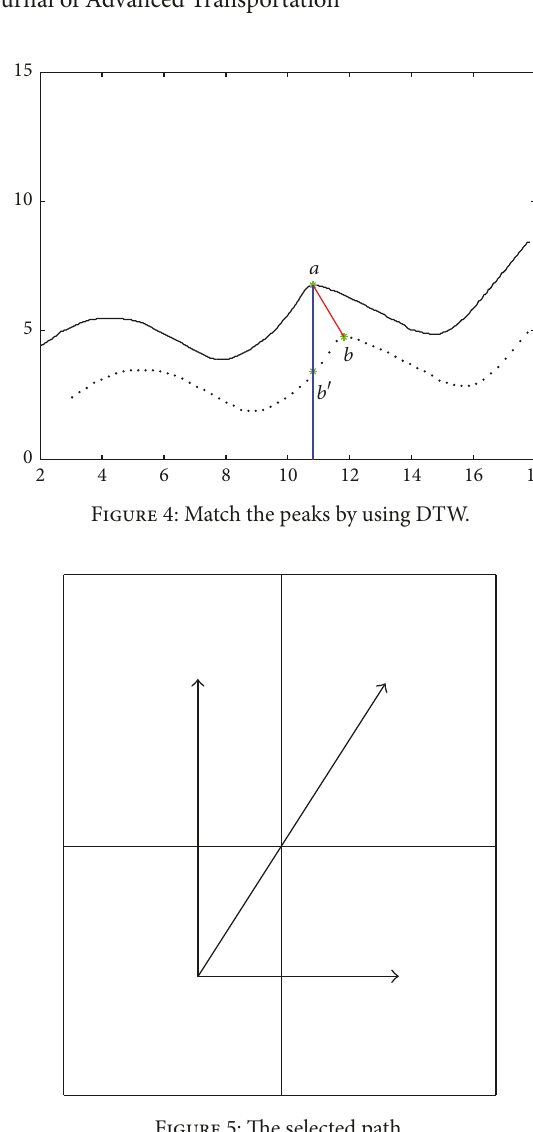
Figure 5: The selected